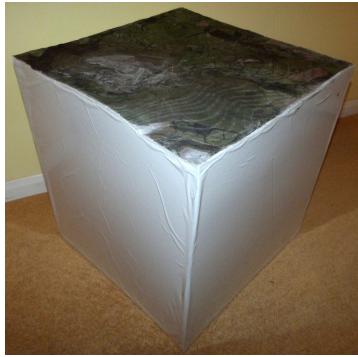
Figure 3. A blank 3-D participatory model used by both expert and non-expert participants during the semi-structured interviews to as- sist with non-verbal